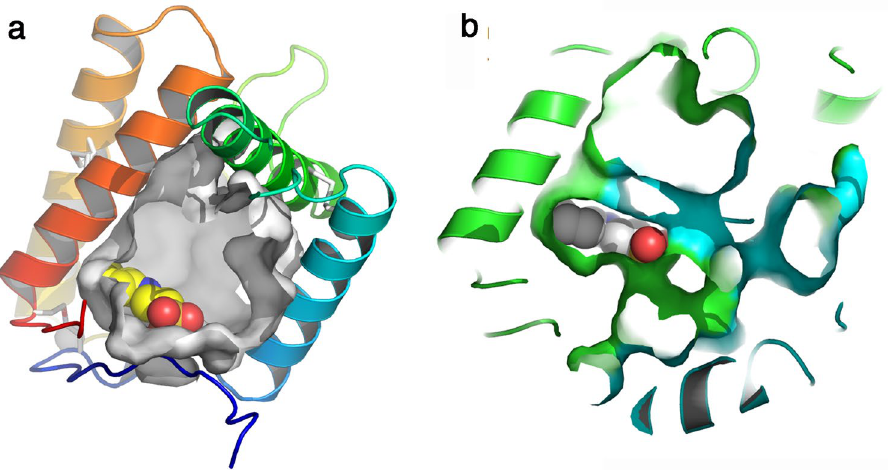
Figure 6. The internal cavity of VdesOBP1 form P2 1 . ( a ) Slabbed ribbon view of a monomer rainbow coloured. The cavity is represented by a grey surface and is wide open. The serendipitously bound buffer molecule 2-(N-cyclohexylamino)-ethane sulfonic acid (NCES) is displayed as atomic spheres (C: white, N: blue and O: red), and is stacked against the cavity wall. ( b ) Slabbed ribbon view of a crystallographic dimer rainbow coloured. The cavity is represented by a green surface originating from monomer 1 and a blue surface from monomer 2. The serendipitously bound buffer molecule NCES is displayed as atomic spheres (C: white, N: blue and O: red), and is stacked against the cavity walls from both monomers. Figure made with PyMOL (version 1.5.0.2. http:// www. pymol. org).